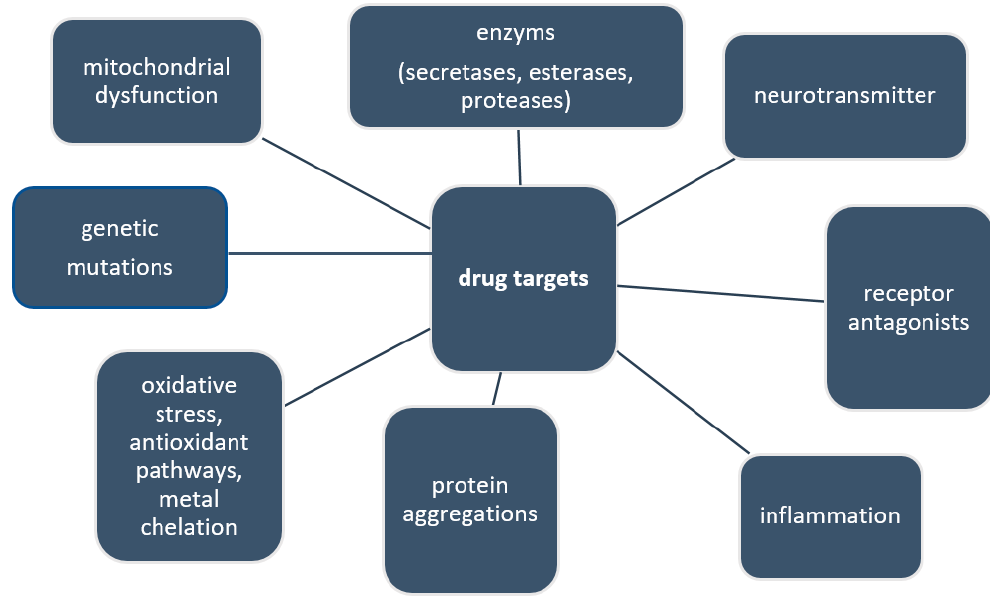
Figure 1 . Examples of drug targets for neurodegeneration. Figure 1. Examples of drug targets for